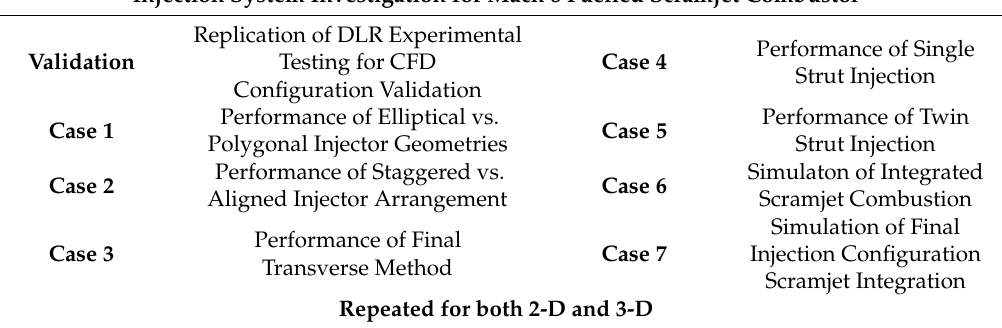
Table 5. Injection system cases investigated.